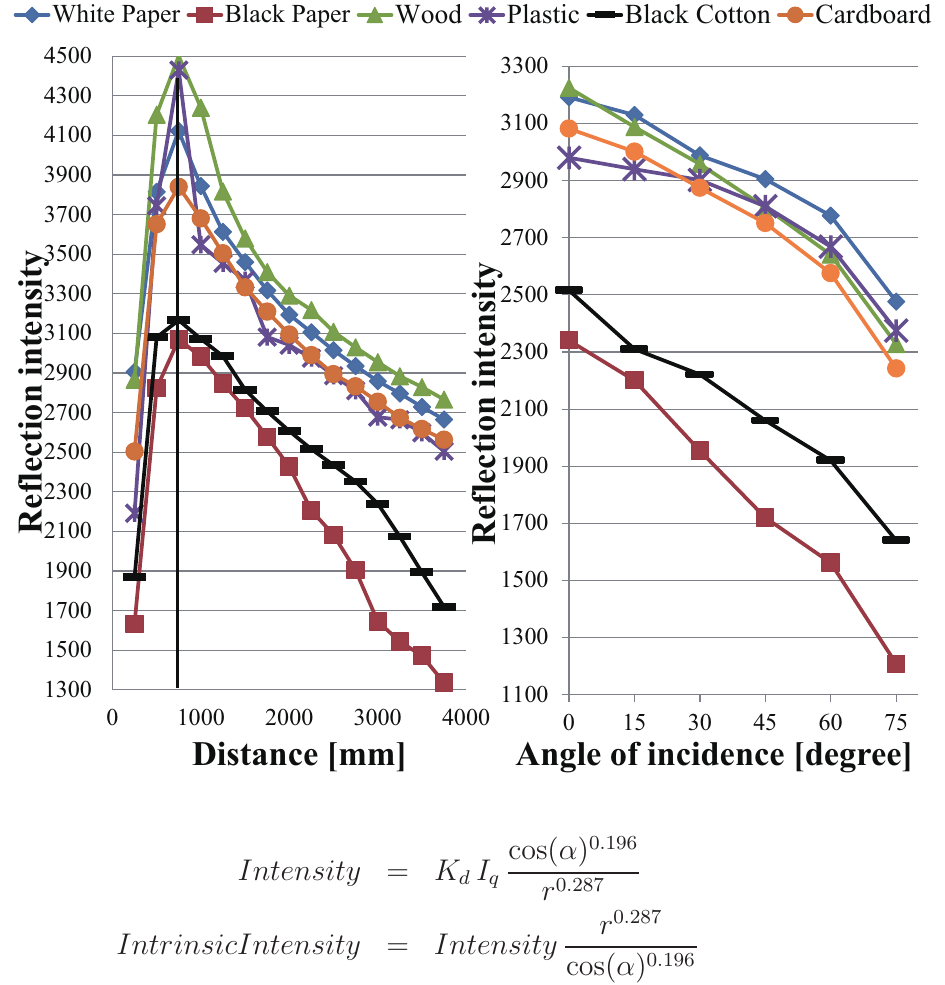
Figure 4. Experiment results of reflection intensity vs . distance and angle of